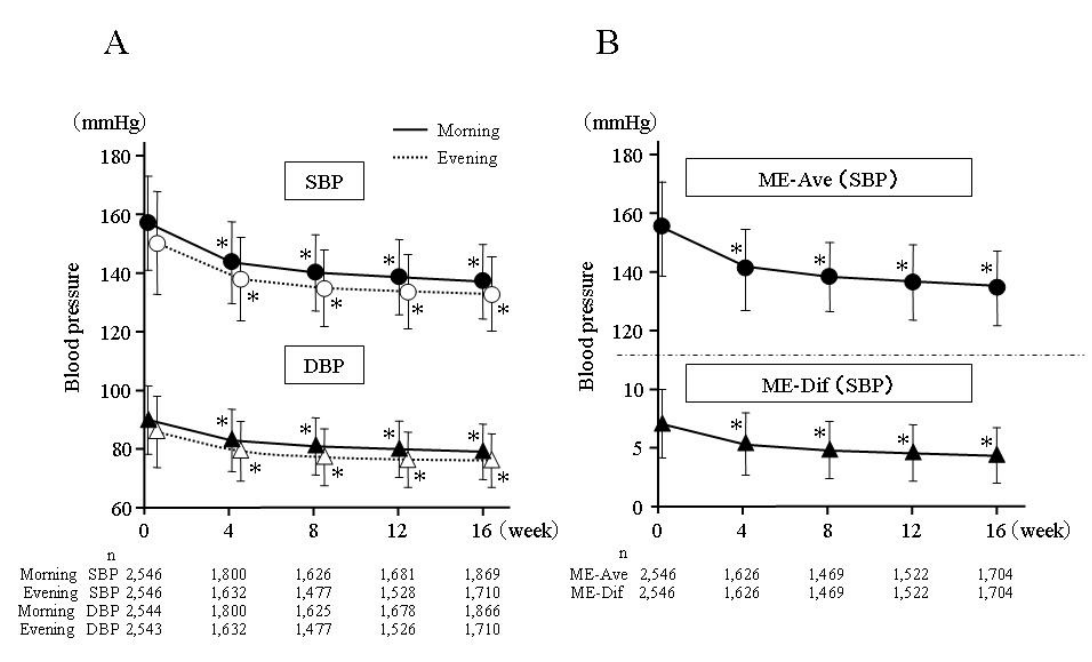
Figure 2. Time-course of change in home morning BP (straight line in A) and evening BP (dotted line in A), ME-Ave (upper graph in B), and ME-Dif (lower graph in